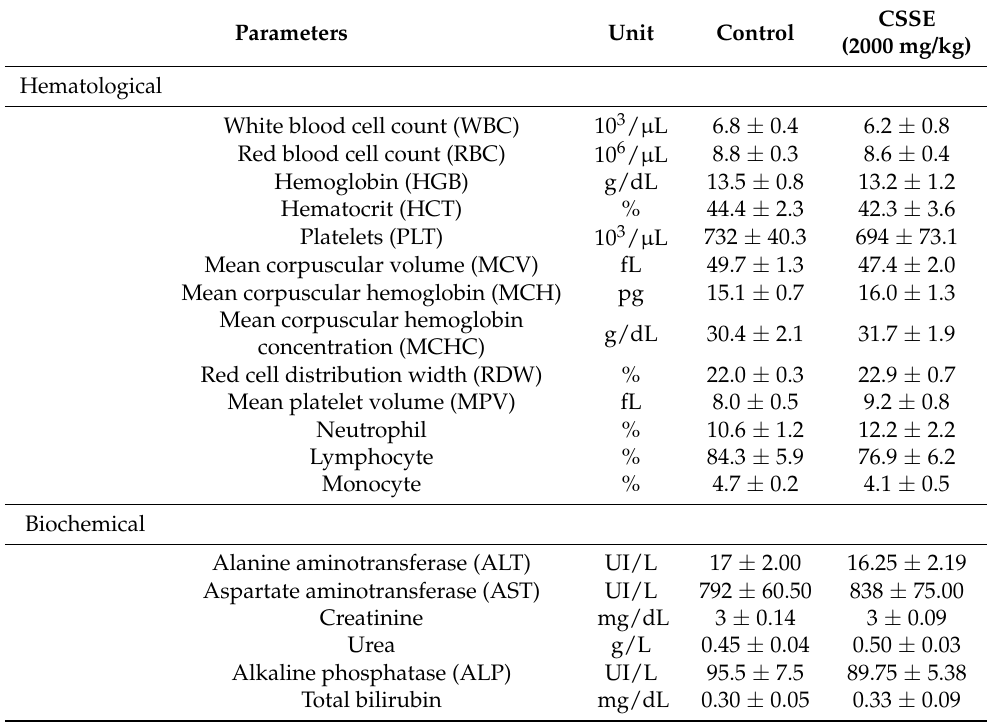
Table 3. Effect of a single oral dose of CSSE on blood hematological and biochemical parameters of mice.